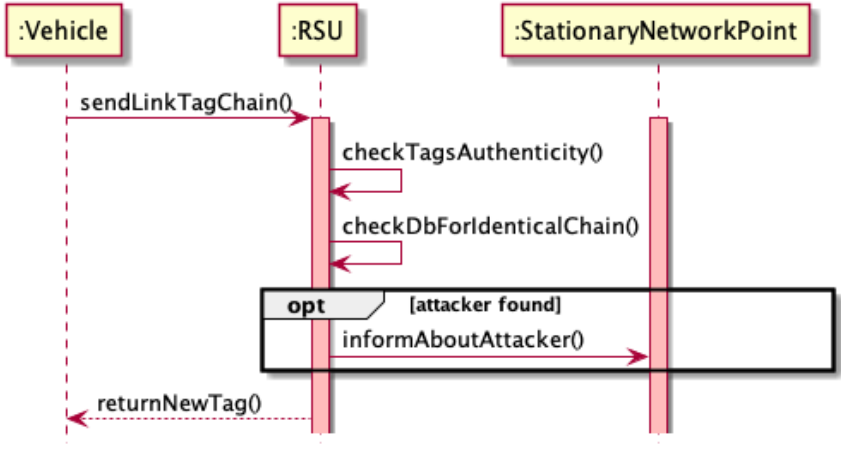
Figure 6. Footprint sequence diagram.